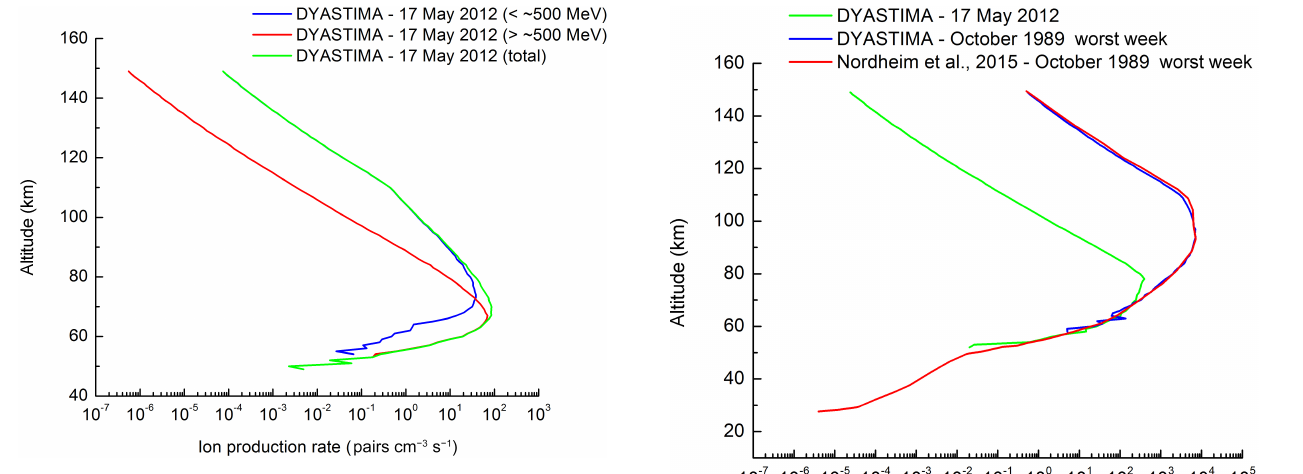
Figure 1. Ionization rate profiles in the Venusian atmosphere due to the arrival and penetration of SEPs during the event on 17 May 2012. The results obtained from the NMBANGLE PPOLA model, scaled to the distance of Venus, were considered as inputs in the DYASTIMA application. The estimations presented here corre- spond to the “peak phase” of the event, considered as the time that the 5min averaged fluxes at proton energies greater than 500MeV (as observed at 1AU and/or modelled) reached their maximum flux.